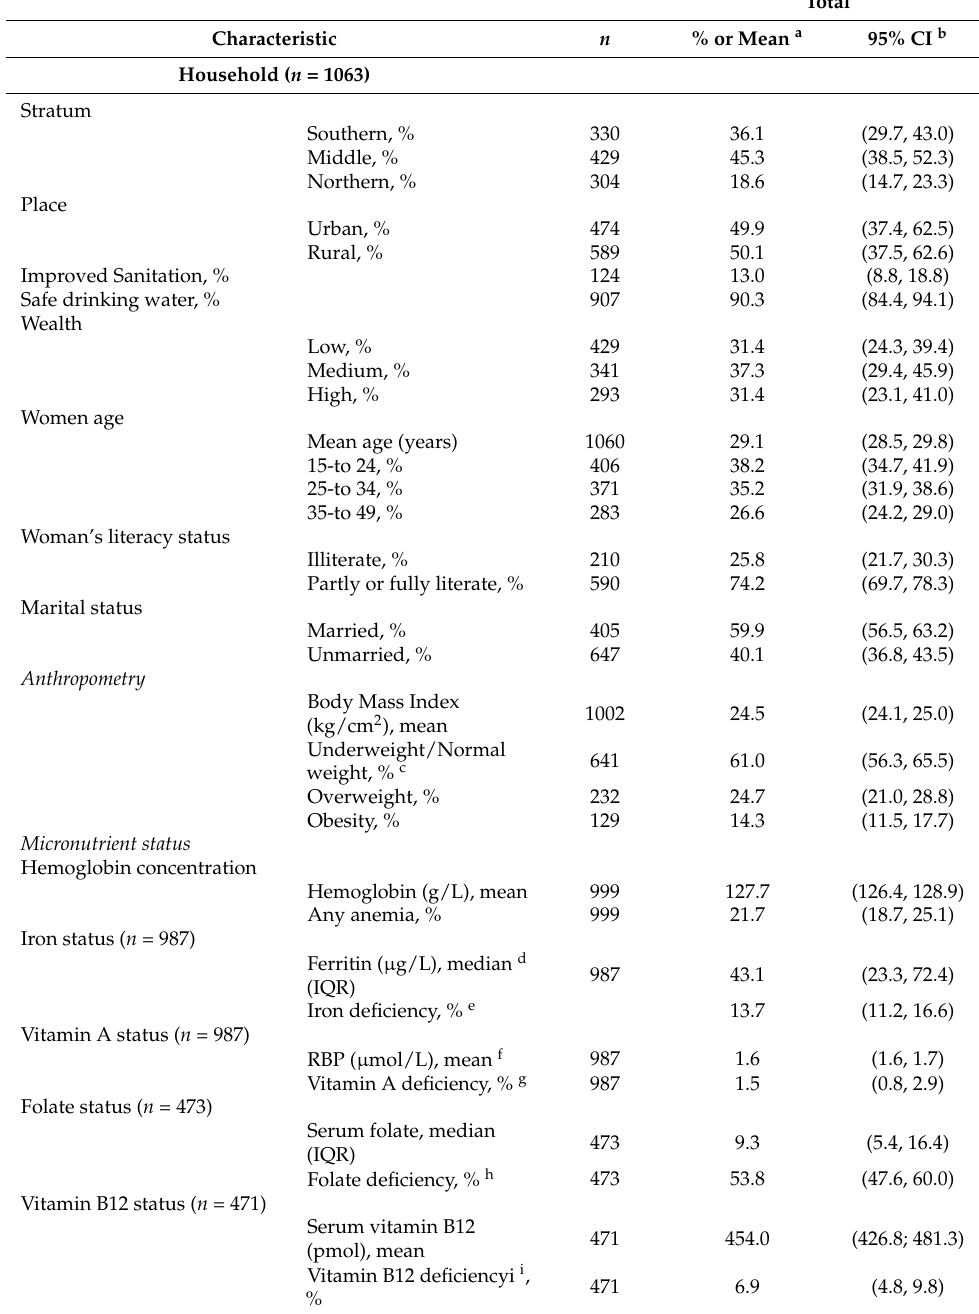
Table 1. Socio-demographics, anthropometry, and micronutrient status among non-pregnant women of reproductive age, Ghana